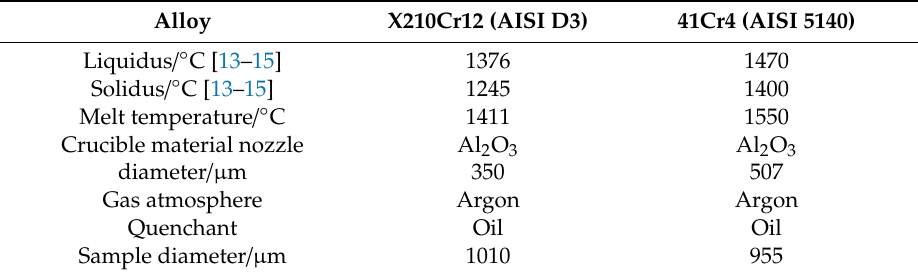
Table 1. Process conditions for sample synthesis.